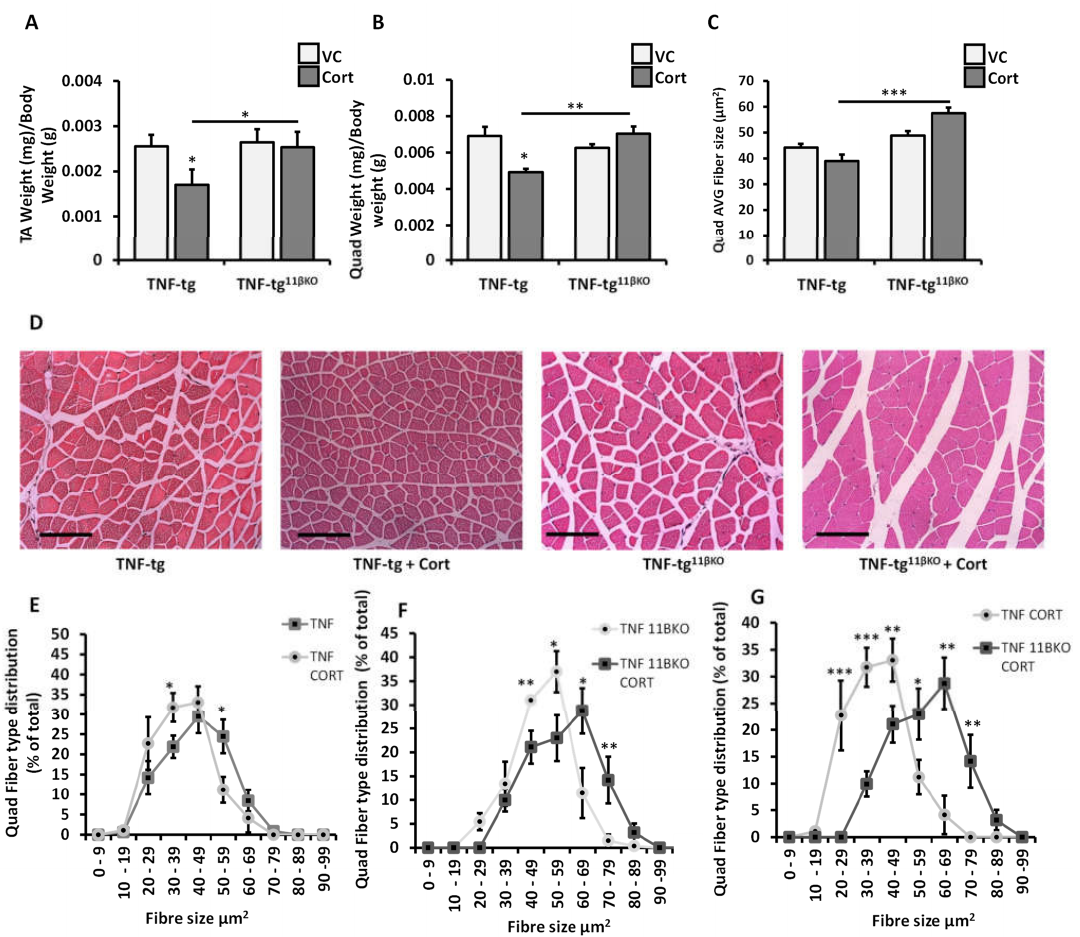
Figure 3. Total ( A ) Tibialis anterior (TA) and ( B ) quadriceps muscle weights relative to total bodyweight and ( C ) average quadriceps muscle fibre cross sectional area (µm 2 ) in TNF-tg, and TNF-tg 11βKO animals receiving either vehicle or corticosterone (100 µg/mL) in the drinking water for 3 weeks. ( D ) Representative images of quadriceps muscle sections and ( E – G ) distribution of quadriceps muscle fibre cross-sectional area determined using Image J in paraffin embedded sections in TNF-tg, and TNF-tg 11βKO animals receiving either vehicle or corticosterone (100 µg/mL) in the drinking water for three weeks. Values are expressed as mean ± standard error of six animals per group. Statistical significance was determined using two-way ANOVA with a Tukey post hoc analysis. * p < 0.05, ** p < 0.005, *** p < 0.001 (scale bars, 50 µm). VC = Vehicle Control, Cort = Corticosterone. Quantitative analysis of average muscle fiber size and distribution yielded matching results. The average fiber cross-sectional area was significantly larger in corticosterone- treated TNF-tg 11βKO mice than in treated TNF-tg mice (57.5 µm 2 vs. 39.0 µm 2 , p < 0.001; Figure 3C and Supplementary Figure S2). Examined in closer detail, corticosterone treat- ment for TNF-tg mice produced a left shift in fiber size distribution (i.e., higher frequency of small fibers and lower frequency of large fibers (Figure 3E)). In contrast, corticosterone treatment for TNF-tg 11βKO mice produced a right shift in fiber size distribution (Figure 3F). When muscle histology of corticosterone-treated TNF-tg and TNF-tg 11βKO animals is com- pared directly, lack of 11β-HSD1 function produces a marked right shift in fiber size